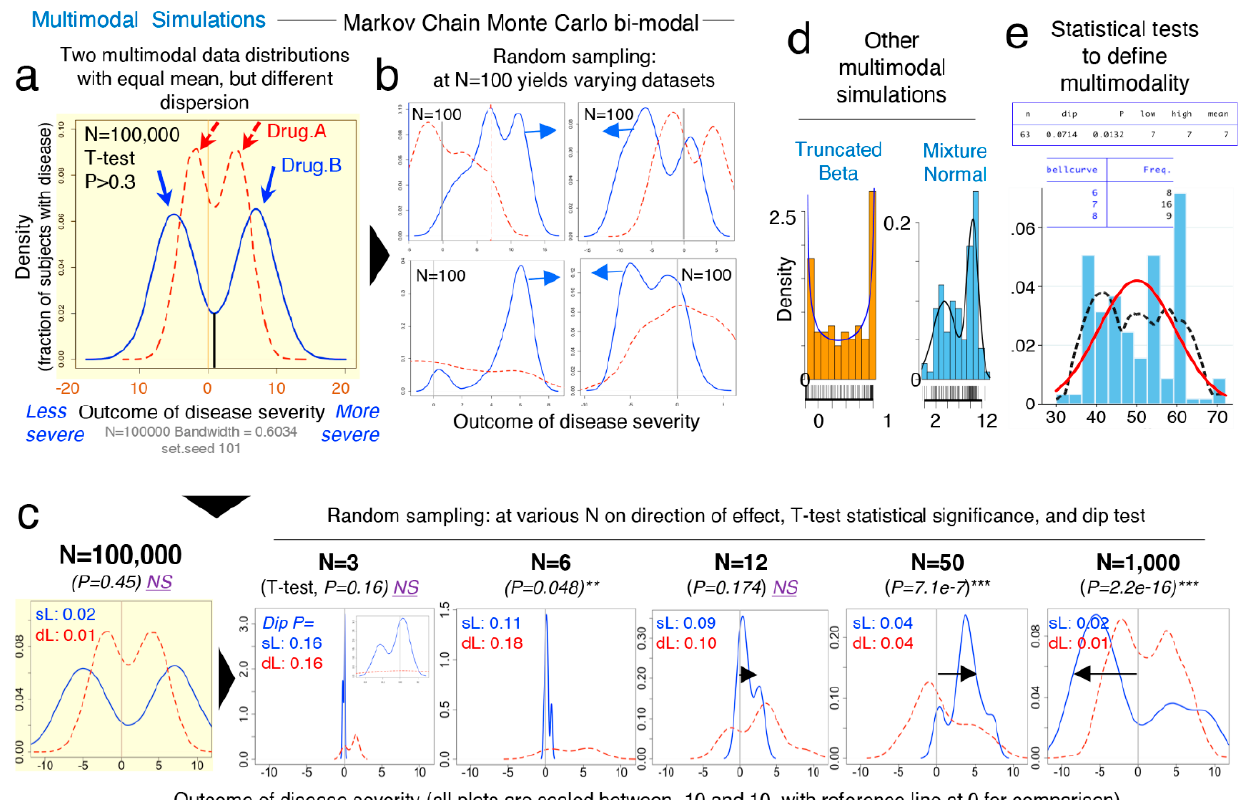
Figure 5. Comparison of two statistically similar multimodal datasets yields highly irreproducible results due to random sampling at various N. Markov chain Monte Carlo (MCMC) simulations emphasize the need to identify disease subtypes for the study of multimodal diseases. MCMC are random-number-generating strategies to simulate two multimodal distributions, wherein a random walk MCMC Metropolis–Hastings’ algorithm simulates random sampling accounting for inter-/within-mode dependence of two “data disease subtypes”. ( a ) MCMC simulations of two statistically similar multimodal datasets (hypothetical effect of “drug A”; red dash line vs. “drug B”; blue solid line), “real” distributions set at N = 100,000; grey reference line at x = 0, downward arrows; data modes. ( b ) Random sampling of multimodal dataset (from panel 5a) at N = 100 yields varying dataset distributions and a different mean, SD. ( c ) Effect of random sampling dataset (from panel 5a) on increasing N on t -test significance and direction of effect for “drug A” vs. “drug B” (arrow), including dip test for MCMC simulations ( set.seed 101). See Supplementary Figure S5 for wider range of N and the STATA and R command scripts for the dip test and modes analyses. ( d ) Example of other multimodal distributions derived from “truncated beta” and the combination of two “mixed unimodal” distribution functions. ( e ) Example of a Hartigan–Hartigan (Hartigans’) unimodality dip test and a modes test [69,83,84] showing a multimodal data distribution (black dotted line) compared to normal univariate density plot (red line). To identify data subtypes (modes), the dip test [69] computes a p -value to help determine unimodal or multimodal; does not require a priori knowledge of potential multimodality; it is interpreted from test statistics (if p < 0.05 data is not unimodal, if p > 0.05–1.0 at least one data mode in dataset). Asterisks indicate significance P < 0.05.